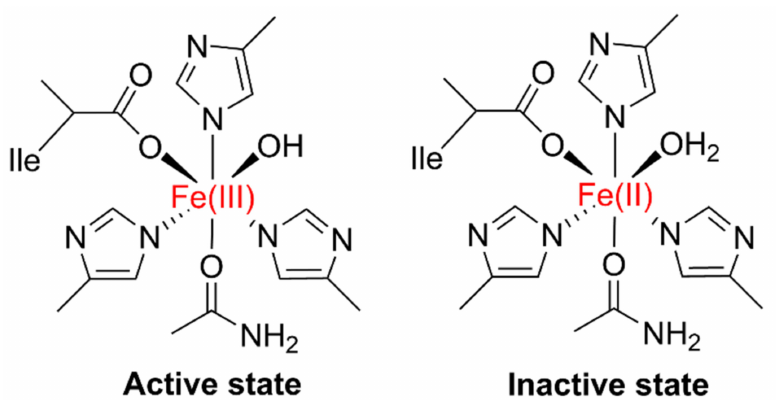
Figure 1. The active and inactive states of LOX. The active state possesses a spin oxidized Fe 3+ whereas the inactive state a high-spin Fe 2+ (reduced